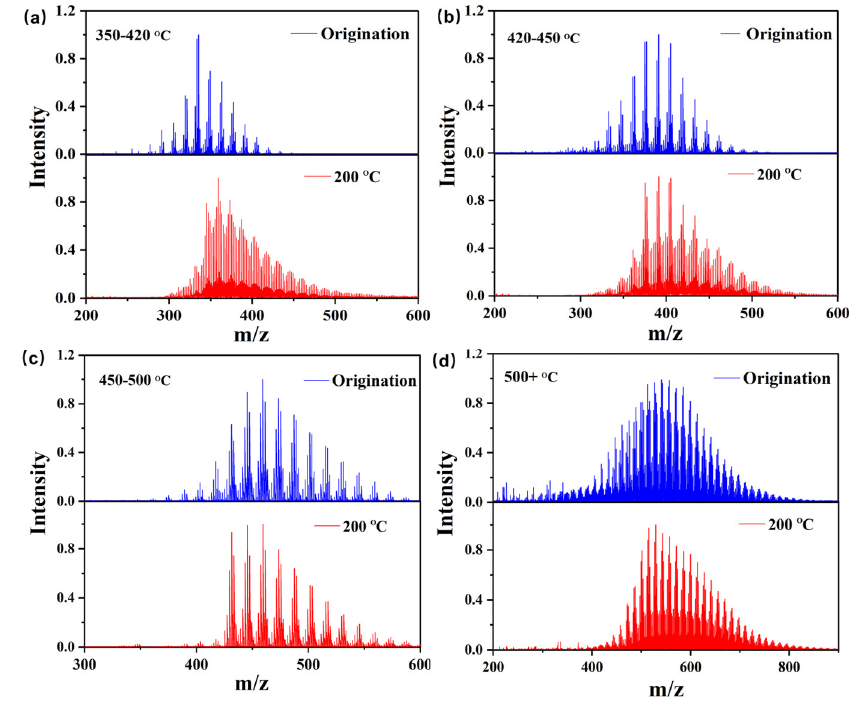
Figure 3. High-resolution spectra of pseudo-components in the range of 25–200 °C: ( a ) 350–420 °C; ( b ) 420–450 °C; ( c ) 450–500 °C; ( d ) 500+ °C.